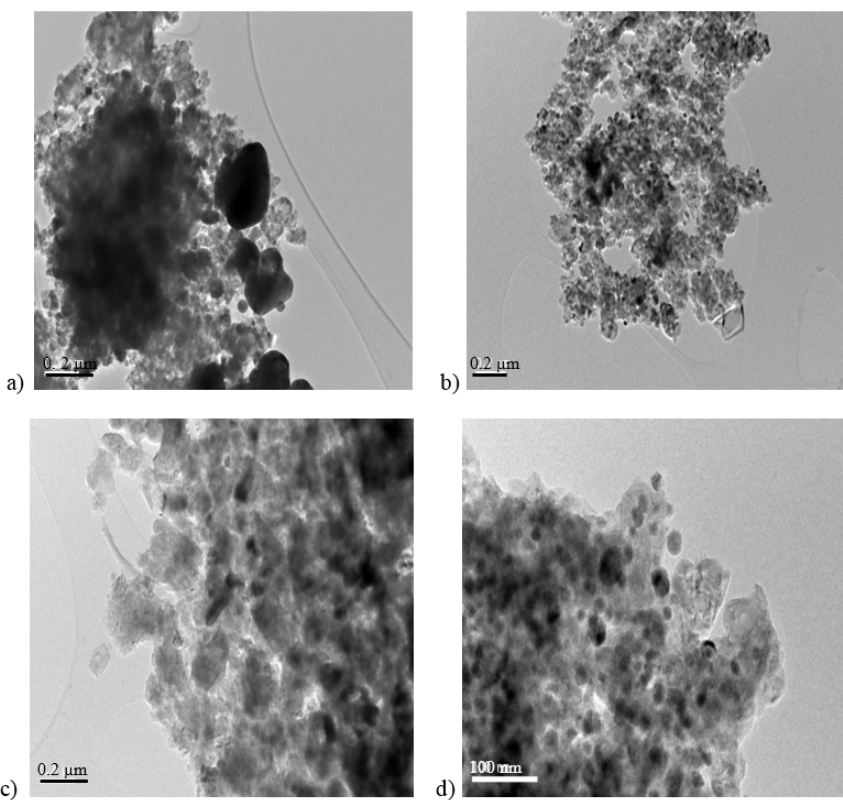
Figure 4. TEM Images: ( a ) CoN/SiC; ( b ) CoA/SiC; ( c ) CoCl/SiC; and ( d ) CoCit/SiC.